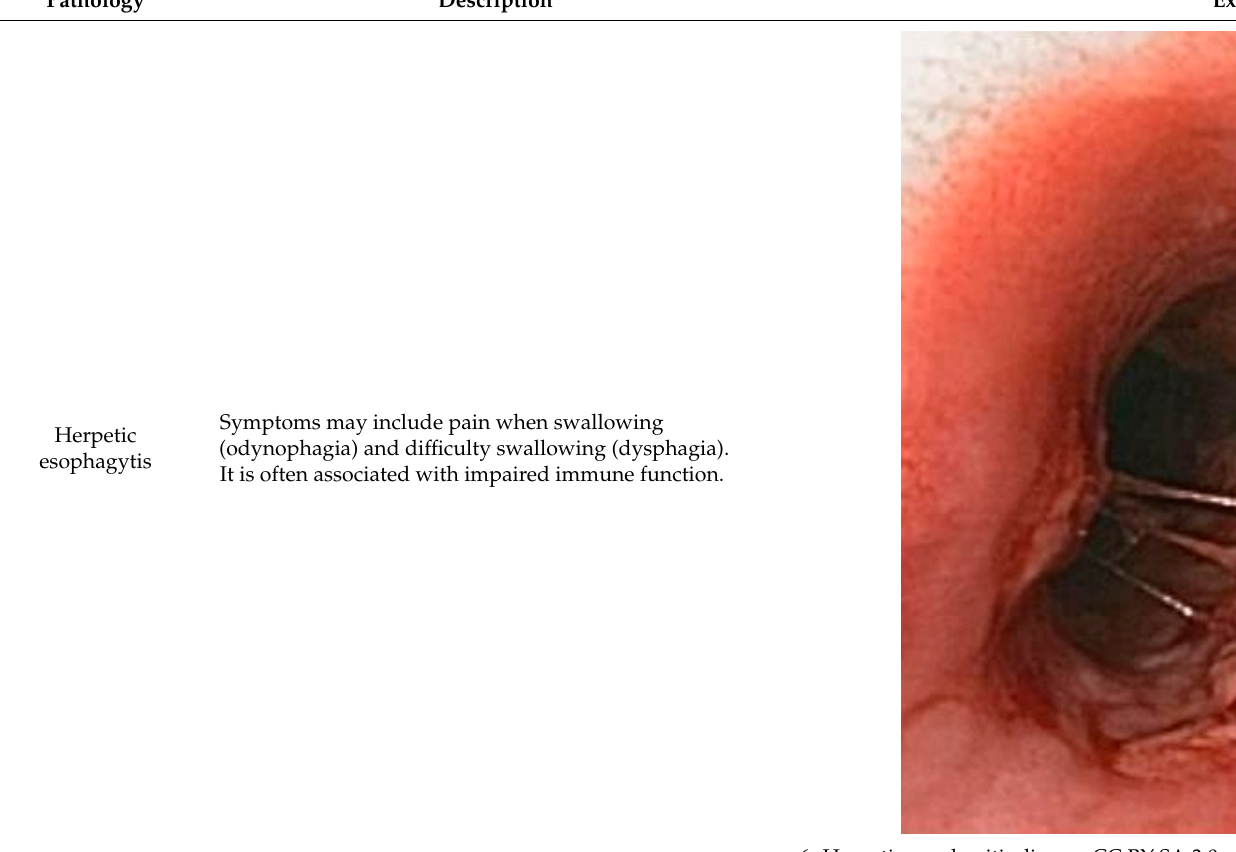
Figure 6. Herpetic esophagitis, licence CC BY-SA 3.0, adapted with concession of Donald E. Mansell, MD